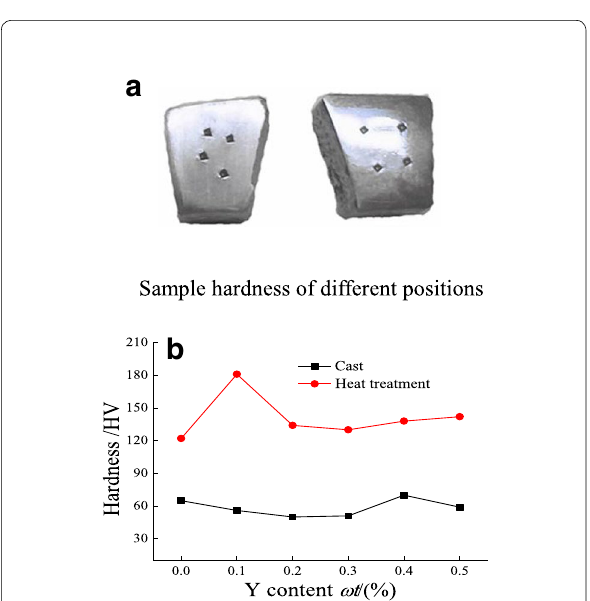
Figure 5 SEM images of the studied alloy with different Y contents